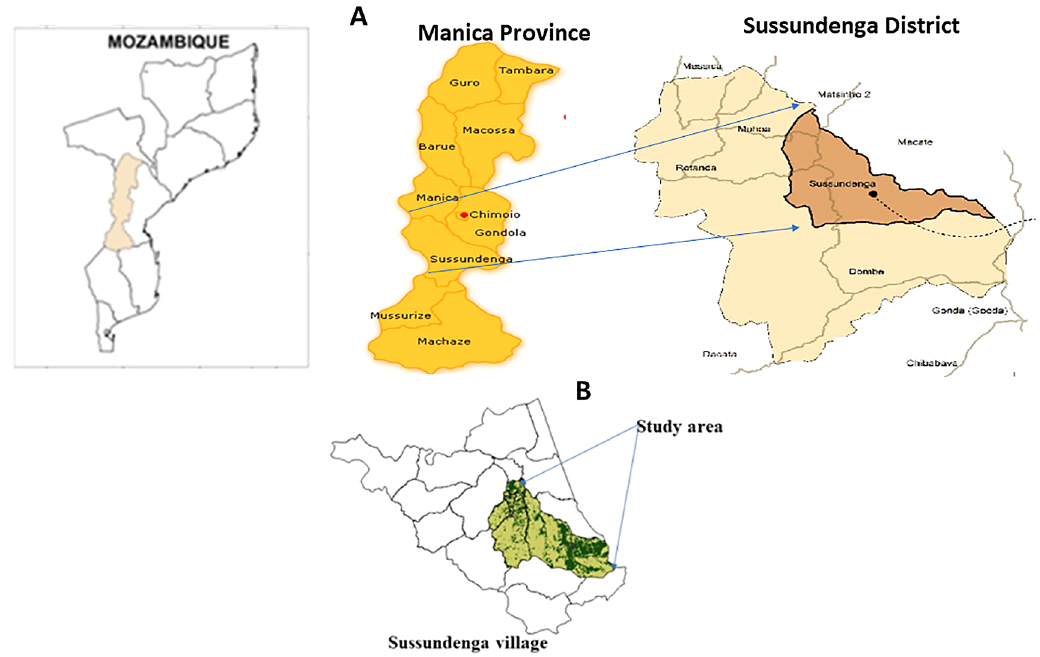
Figure 1. Study area. A. Map of Mozambique, Manica province and Sussundenga district: adapted from National Cartography and Remote Sensing Centre (CENACARTA). 14 B. Sampled site in Sussundenga village: adapted from CENACARTA.